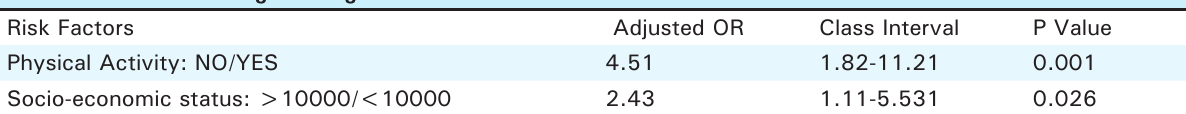
Table 6. Multivariate Logistic